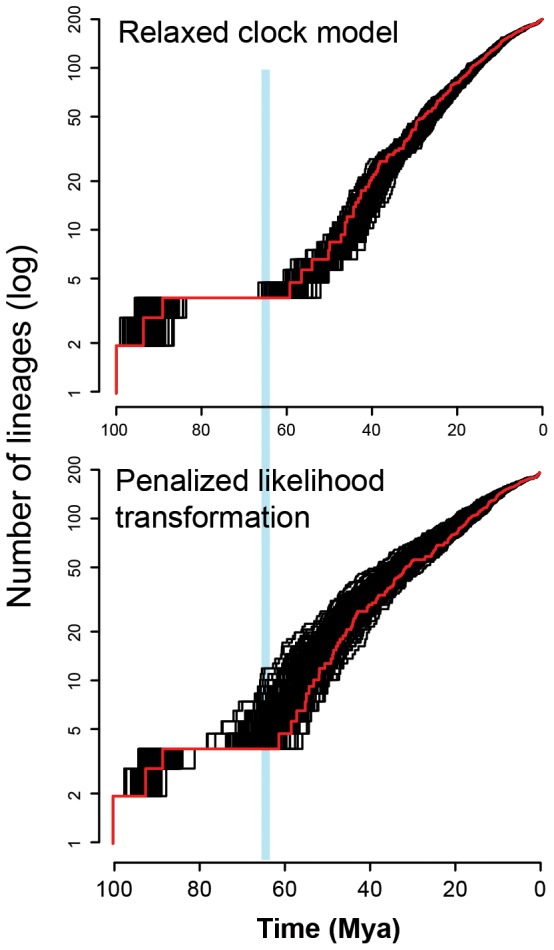
Log lineage through time (LTT) plots for Xylocopinae.Top panel gives results for an uncorrelated log normal relaxed clock (RC) model and the bottom panel gives results for a penalized likelihood (PL) transformation of MrBayes phylograms. The red lines indicate the maximum credibility tree for the RC analysis in the top panel and the PL-transformed consensus phylogram for the MrBayes/r8s analysis. Black lines indicate LTT plots for 200 post-burnin trees from each analysis. The blue line represents the K-T boundary.